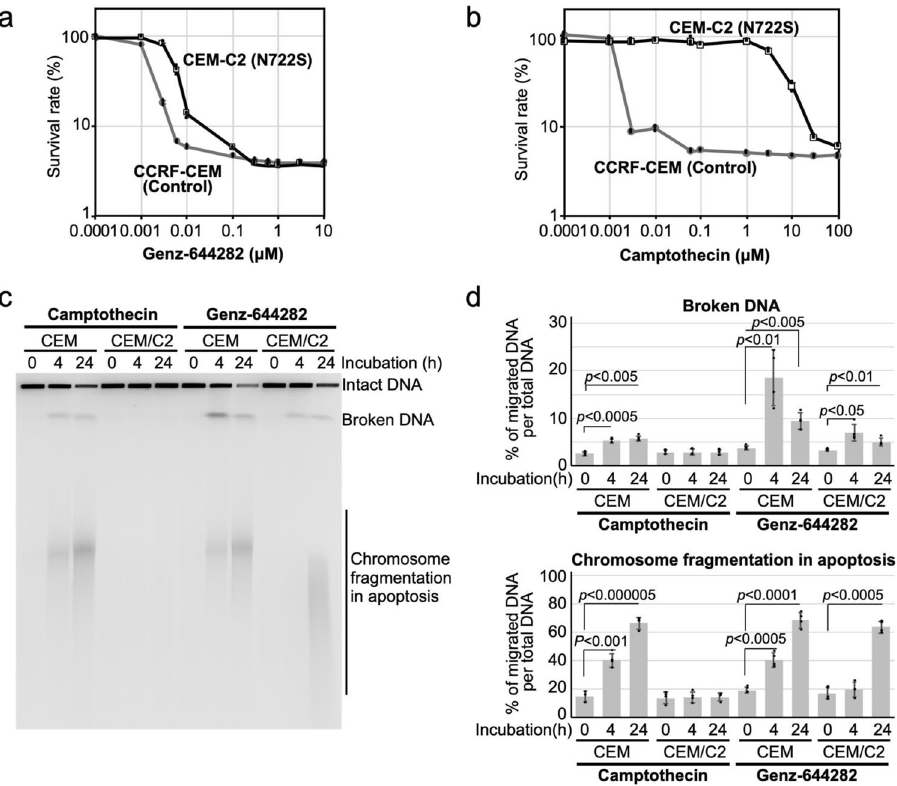
Fig. 4 Characterisation of the cytotoxic effects of Genz against CPT-resistant cells, CEM/C2 cells, carrying N722S mutations in the TOP1 gene. a , b Survival curve of CCRF – CEM and CEM/C2 after treatment with Genz ( a ) and CPT ( b ). c Analysis of DSB formation by PFGE after treatment with CPT and Genz using CPT-resistant cell line CEM/C2 and its control (CCCRF-CEM). Cells were treated with 1 μ M CPT and 1 μ M Genz for 4 and 24 h. d Quanti fi cation of broken DNA per total DNA and chromosome fragmentation per total DNA after treatment with CPT and Genz. The means and standard deviations were determined from four independent